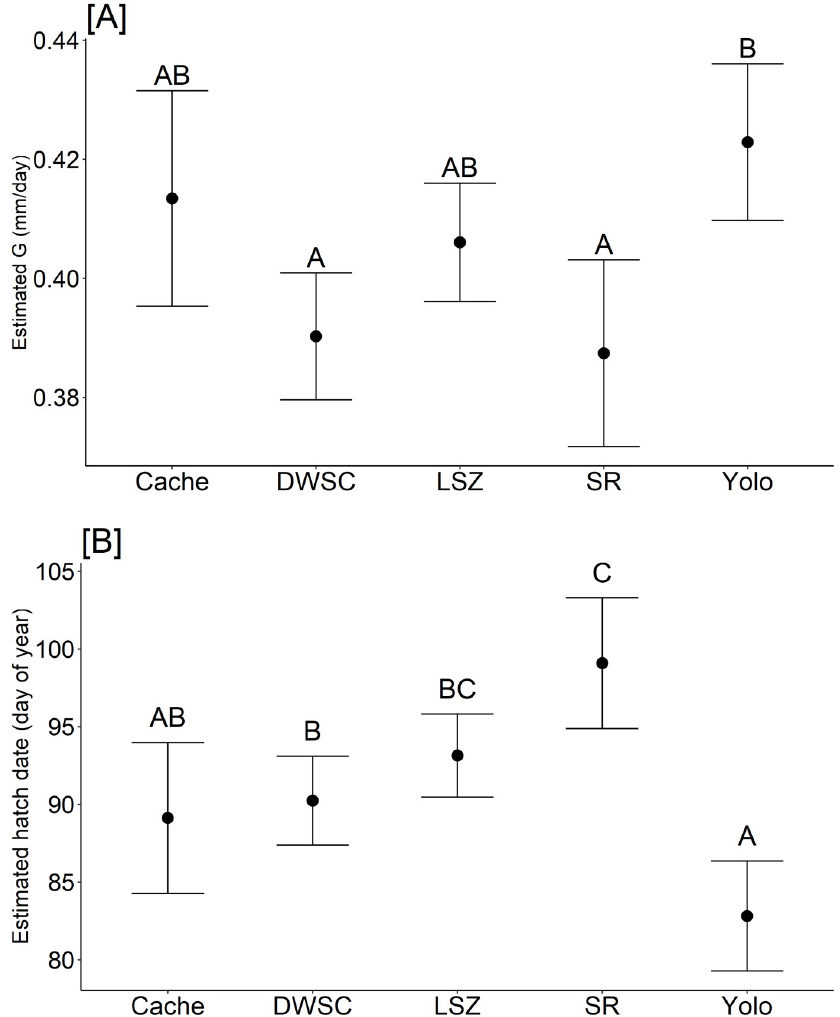
Fig 6. Estimated mean a.) individual growth rate and b.) hatch date by region based on our GLMM. Error bars are the 95% confidence intervals for each region. Letters above error bars denote grouping with significant differences at α = 0.05 after Bonferroni-Holm correction (e.g. A and B regional difference was statistically significant, and as such regions labeled AB were not statistically different from regions labeled as either A or B). Region codes are as follows: